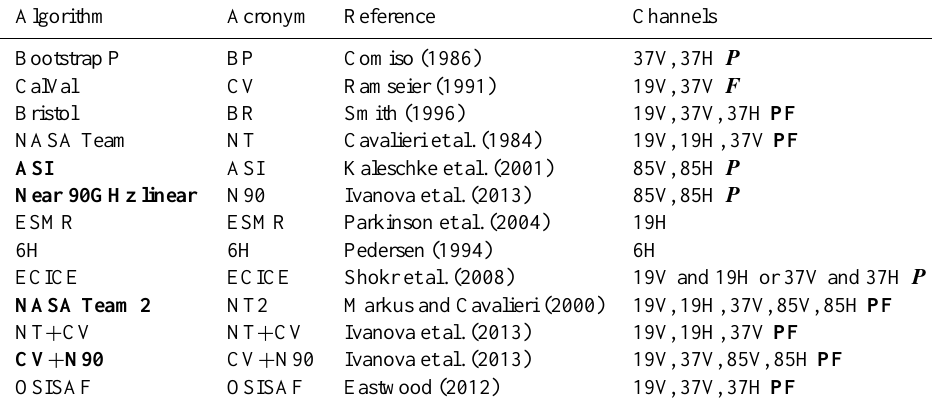
Table 1. The sea ice concentration (SIC) algorithms shown in this study. Algorithm